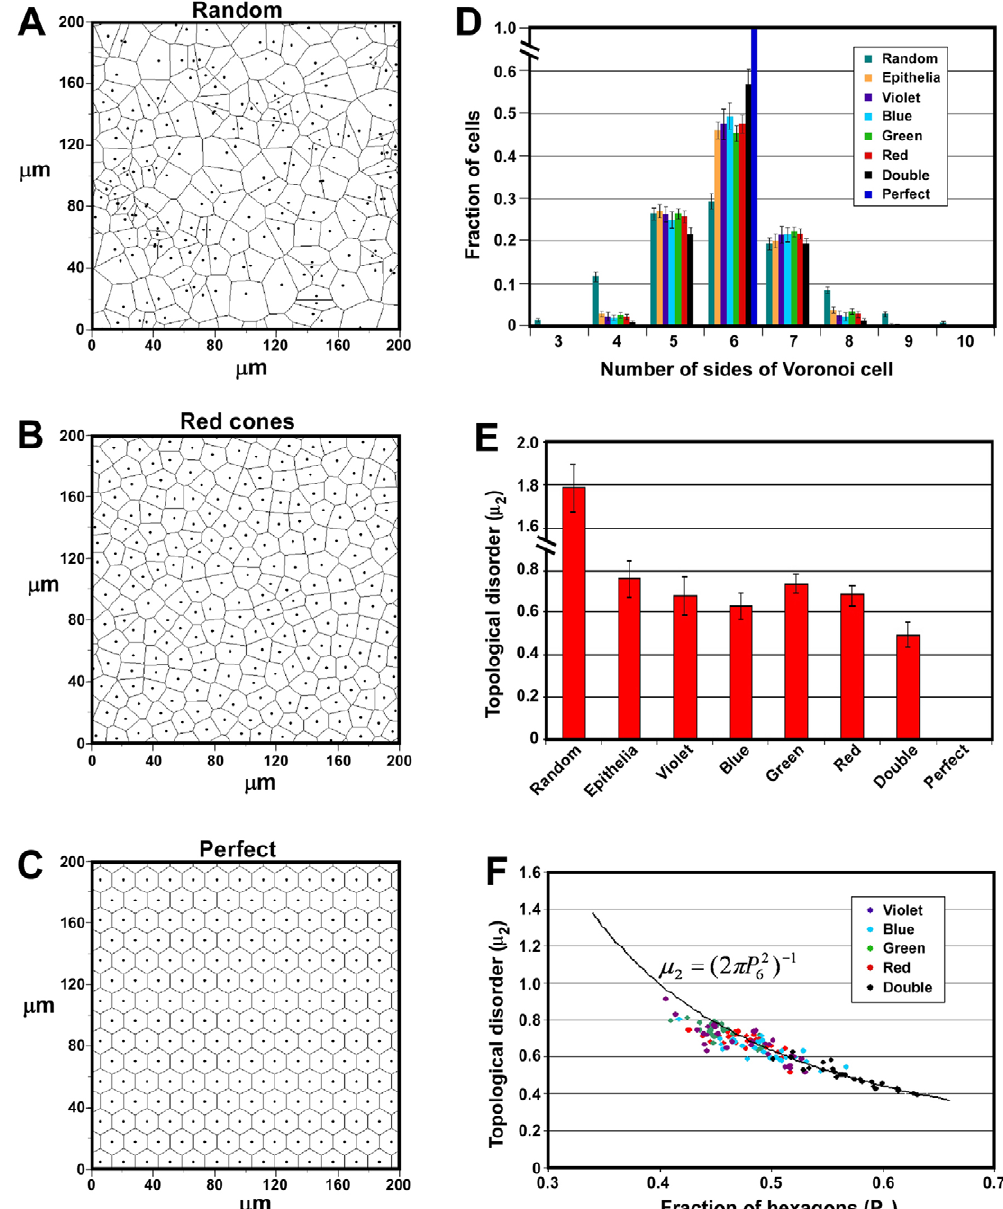
Figure 4. Cone mosaics show a high degree of topological order. (A–C) Voronoi tessellations of a portion of a red cone field (B) and a random (A) and perfect (C) distribution of points of the same density as in (B). (D) Graph showing the average P n distributions for all chicken cone types as well as simulated random and perfect distributions. ‘Epithelia’ indicates the average P n distribution for five different animal and plant epithelia as given in [Ref. 38]. Note that the P n distribution for the random simulations included a small number of 11-, 12- and 13-sided cells which are not shown. Error bars are SD. (E) Graph showing the topological disorder ( m 2 ) for all five cone types as well as random and perfect distributions. ‘Epithelia’ are as described in (D). Error bars are SD. (F) Graph of P 6 vs. topological disorder ( m 2 ) for all 140 P15 cone mosaics examined. The solid curve indicates the value of Lemaıˆtre’s law (equation shown in the graph) in the range, 0.34 , P 6 , 0.66.